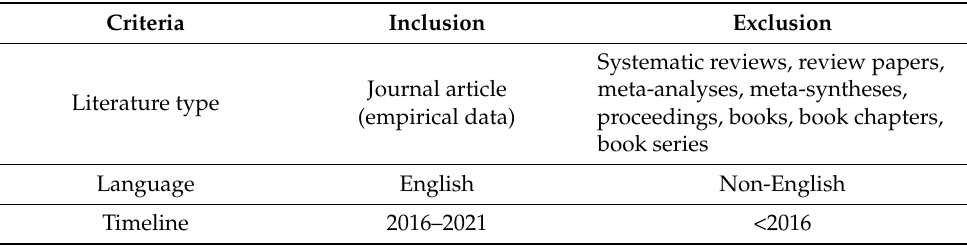
Table 2. The inclusion and exclusion